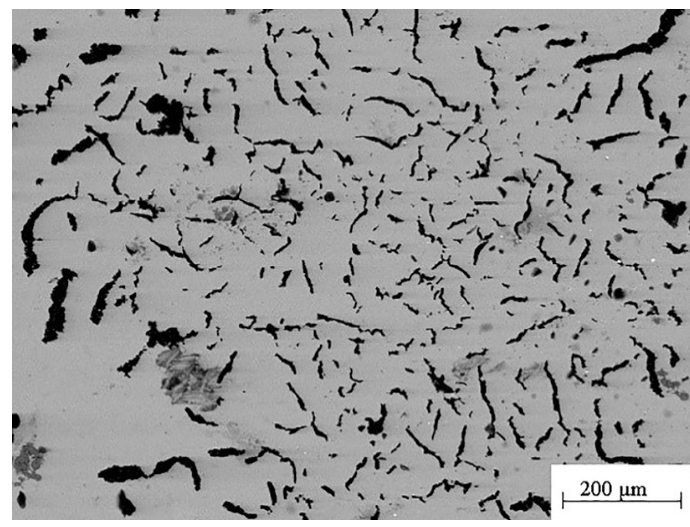
Figure 3. Microstructure of the compacted graphite iron.